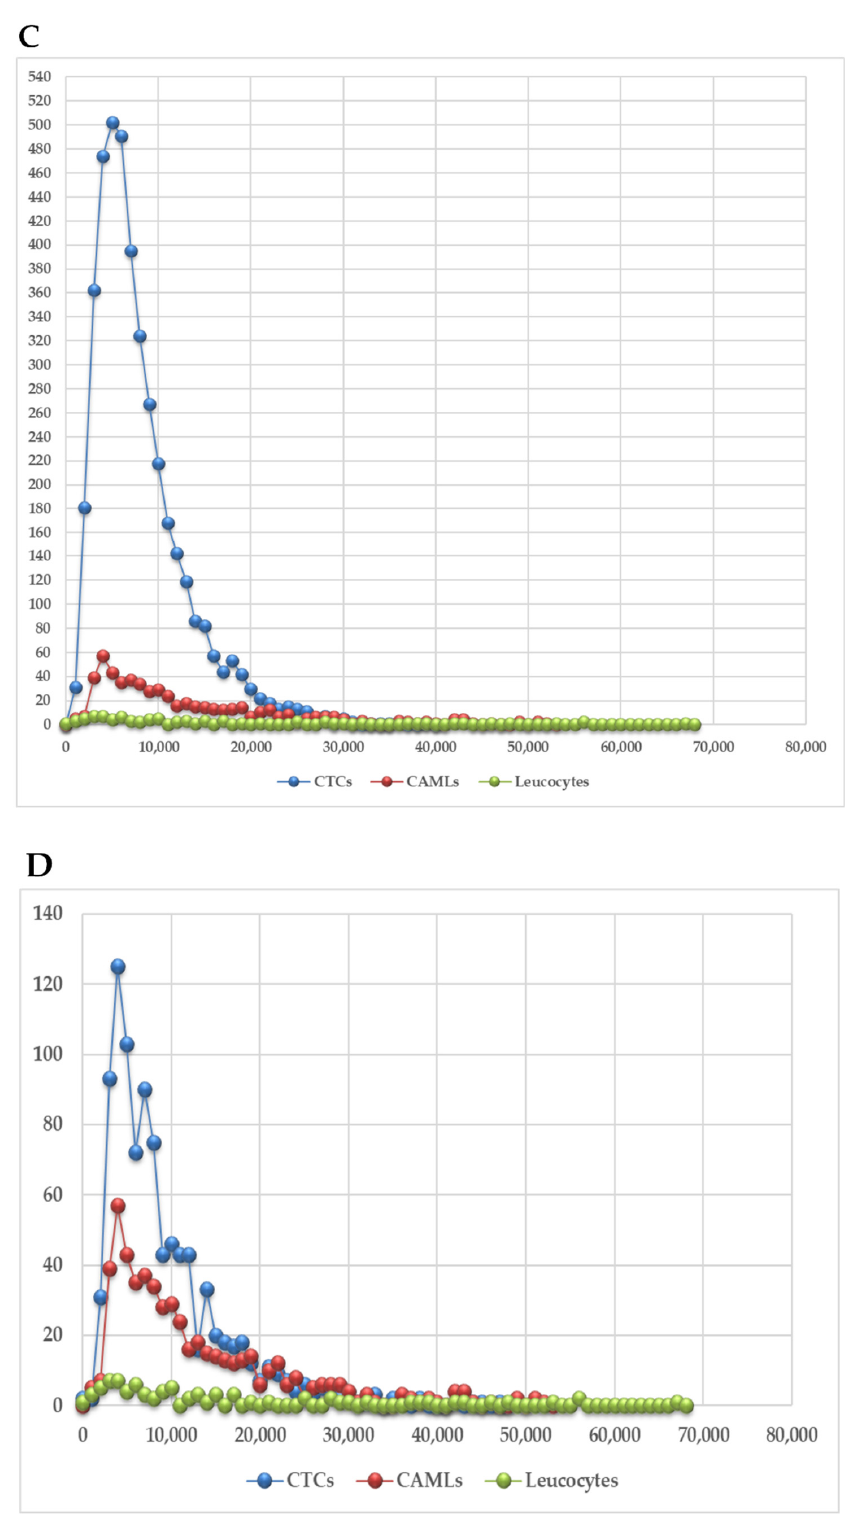
Figure 5. Representative examples of the CTCs, CAMLs, and normal leucocytes 3D telomere profile for patients assigned to profile 1 ( A , B ) and profile 2 ( C , D ). The X-axis shows the number of telomeres and the y-axis represents the telomere length in arbitrary units of fluorescence (a.u). CTCs, CAMLs, and leucocytes are demarked with colors. The graphs correspond to patient 7 ( A ), patient 3 ( B ), patient 1 ( C ), and patient 2 ( D